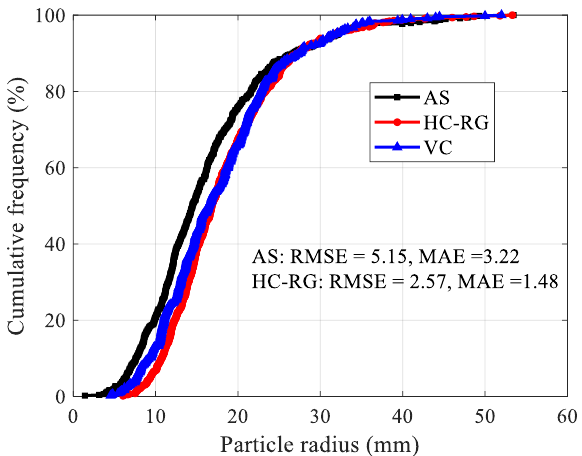
Figure 11. Particle radius distribution of gravel.